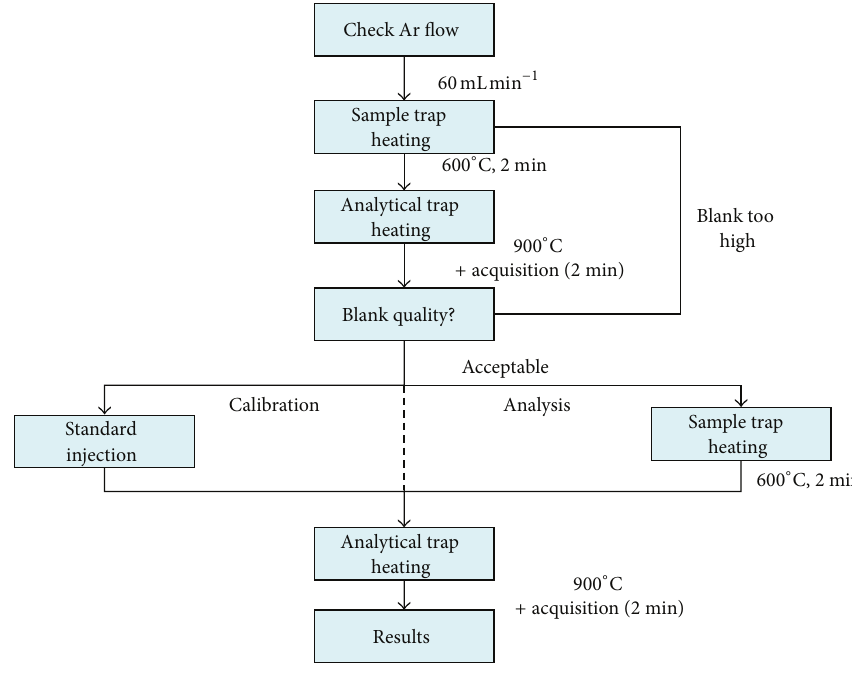
Figure 2: Analytical protocols for Hg standards calibration and TGM analysis. Table 1: AFS signals (area) obtained with Au/TiO trapusing 50 and 100mL removable needle syringes (50 RN and 100 RN, resp.). 2 Volume of injected Hg 0 ( 𝜇 L)